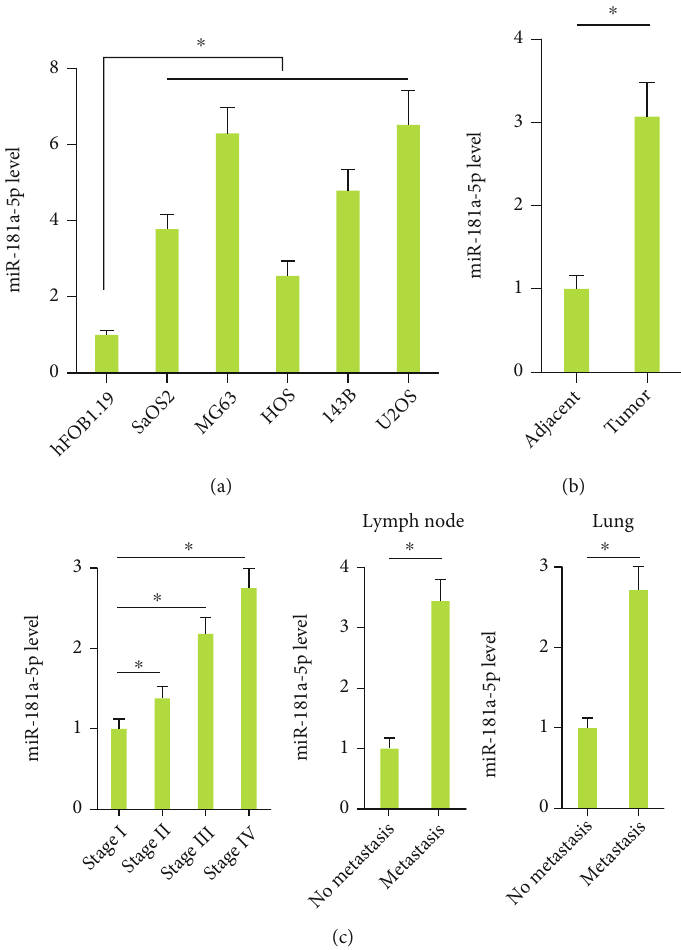
Figure 1: miR-181a-5p level is elevated in human osteosarcoma cells and tissues. (a) Relative miR-181a-5p level in di ff erent osteosarcoma cells and healthy human osteoblast cell ( n = 6 ). (b) Relative miR-181a-5p level in human osteosarcoma and adjacent normal samples ( n = 9 6). (c) Relative miR-181a-5p level in human osteosarcoma samples was analyzed according to the tumor stage and metastasis status ( n = 12 ). All data are presented as the mean ± SD , ∗ P < 0 : 05 versus the matched